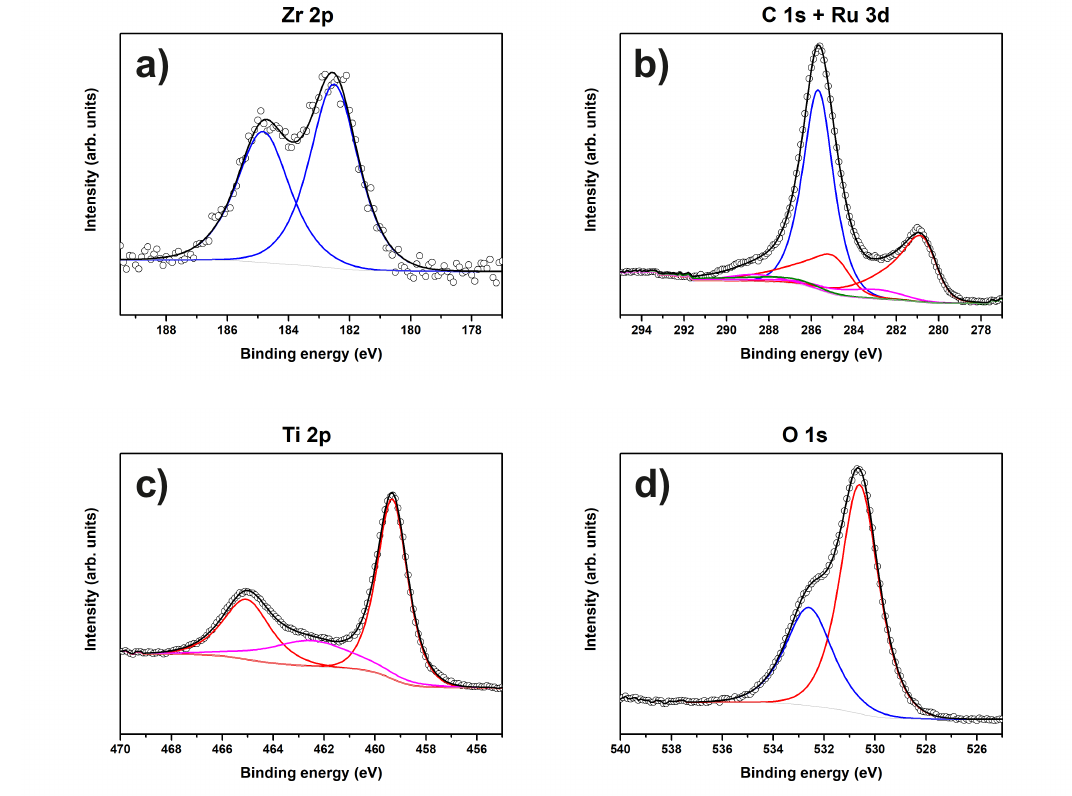
Figure 15. XP spectra of sample “Ru/Ti-1”. The peaks of ( a ) Zr 2p, ( b ) C 1s and Ru 3d, ( c ) Ti 2p, and ( d ) O 1s and corresponding fits are